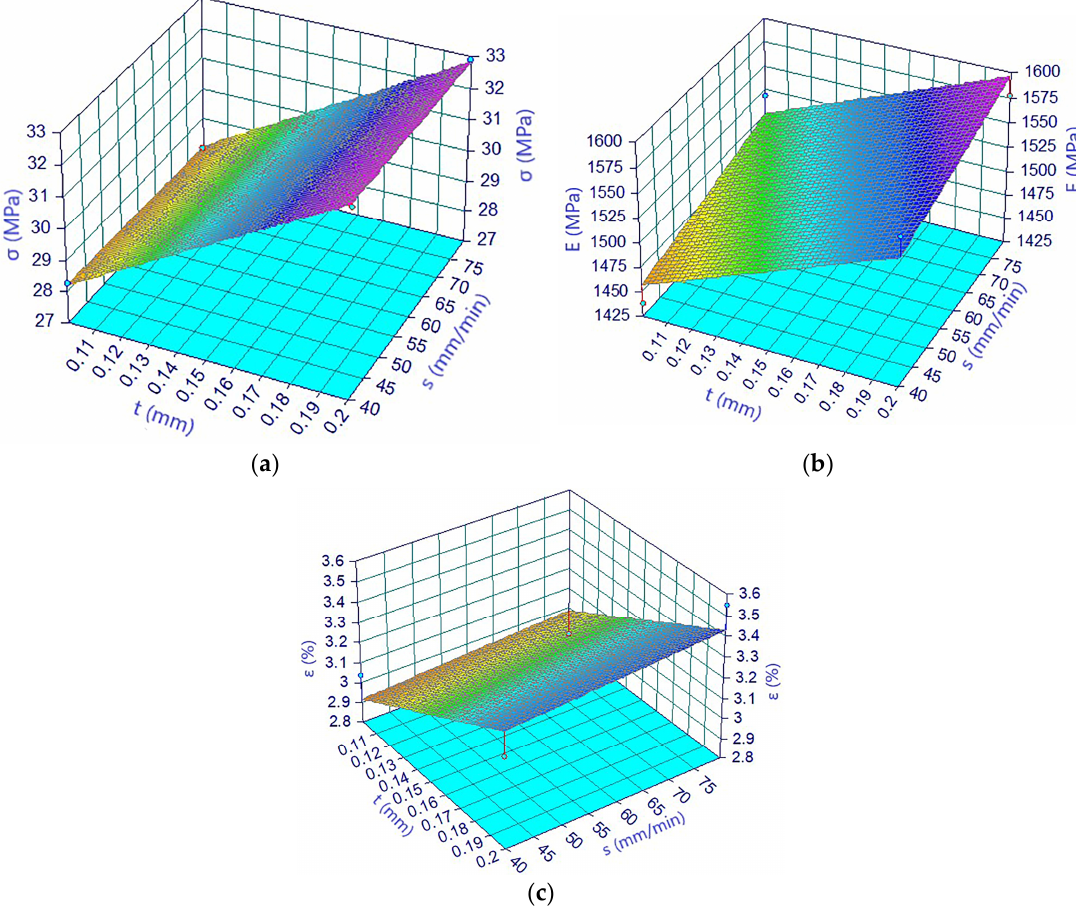
Figure 5. The regression equation for: ( a ) tensile strength; ( b ) modulus of elasticity; ( c ) elongation and samples printed on the edge from the Extrudr BDP Flax filament.